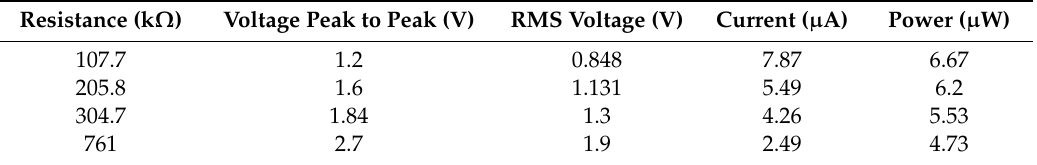
Figure 8. Output voltage of the pVEH microdevice under mechanical vibrations at 37 Hz and 1.5 g acceleration. Table 1. Electrical response of the flexible pVEH microdevice with ZnO nanorod film. Resistance (k Ω )